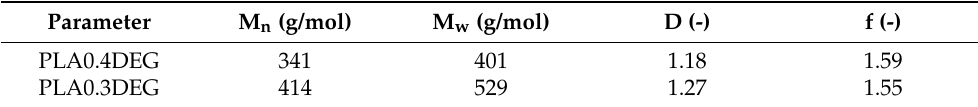
Table 4. Results of GPC analysis and functionality of eco-polyols based on PLA